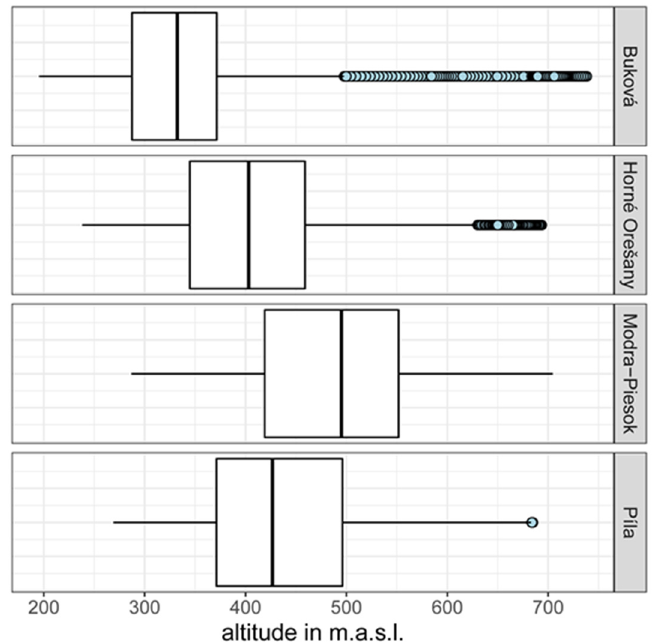
Figure 4. Distribution of altitudes, evaluated by boxplots.